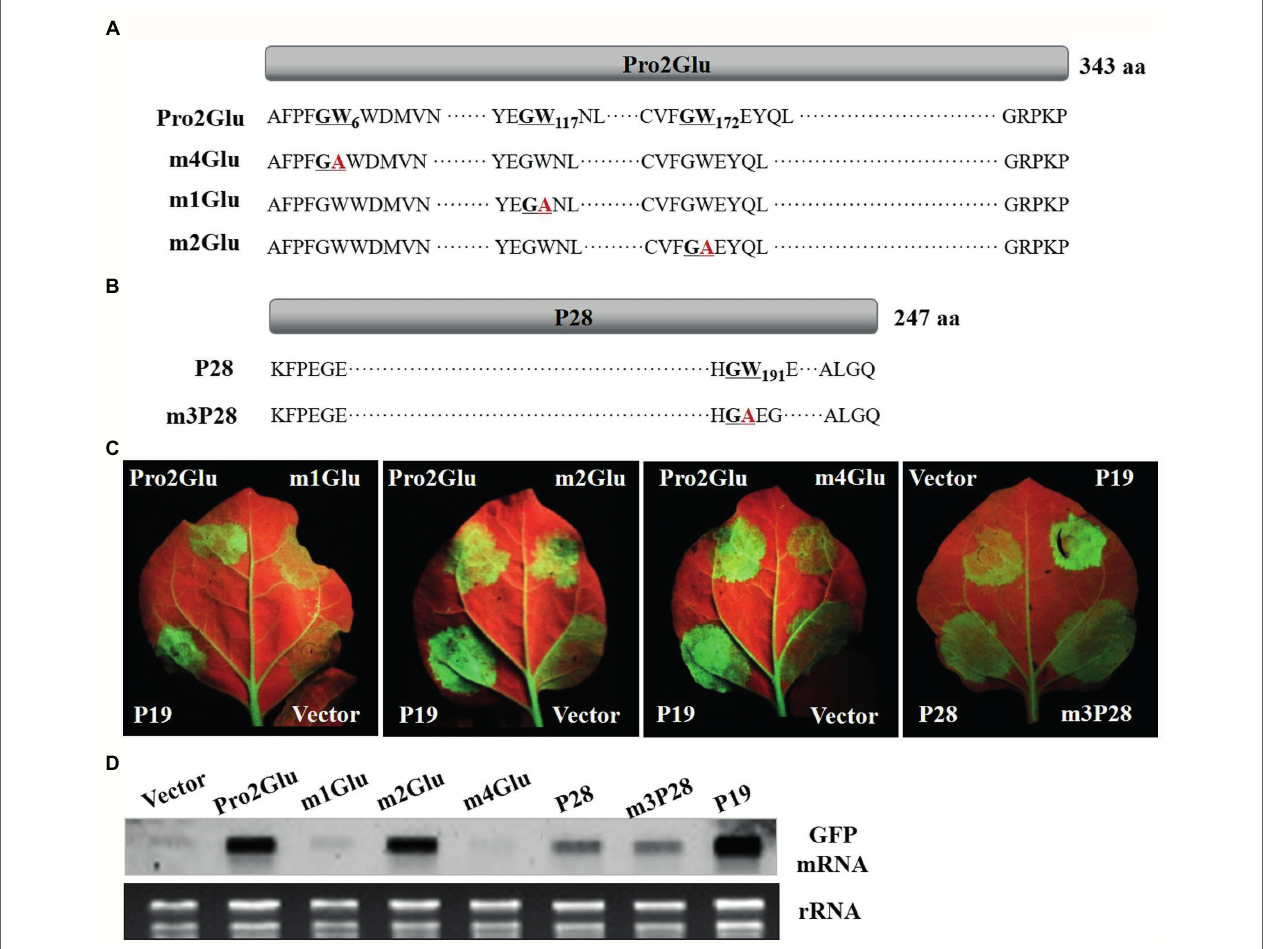
FIGURE 5 | The effect of GW motifs on the suppressor activity of Pro2Glu and P28. (A) Schematic representation of Pro2Glu and the mutation sites of its mutants. (B) Schematic representation of P28 and the mutation site of its mutant. (C) The observation of GFP fluorescence in leaves of N. benthamiana 16c infiltrated with Agrobacterium cultures containing 35S-GFP, plus pCHF3-Pro2Glu, pCHF3-P28 or their derivatives at 4 dpi. Expression of 35S-GFP with pCHF3-P19 or pCHF3 vector served as positive or negative controls, respectively. (D) The analysis of GFP mRNA in infiltrated leaf patches by Northern blot at 4 dpi. The each RNA of lane of Vector, Pro2Glu and P19 is the same as used in Figure 4D